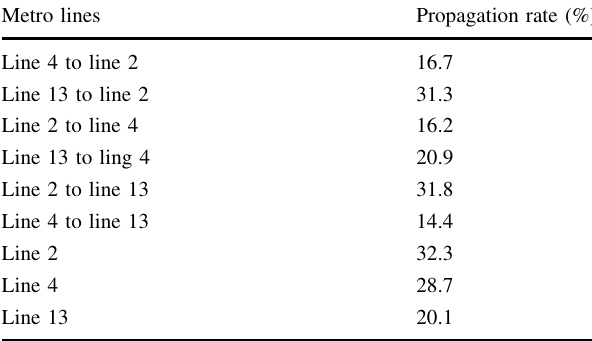
Table 8 Congestion propagation rate k peak at different lines Metro